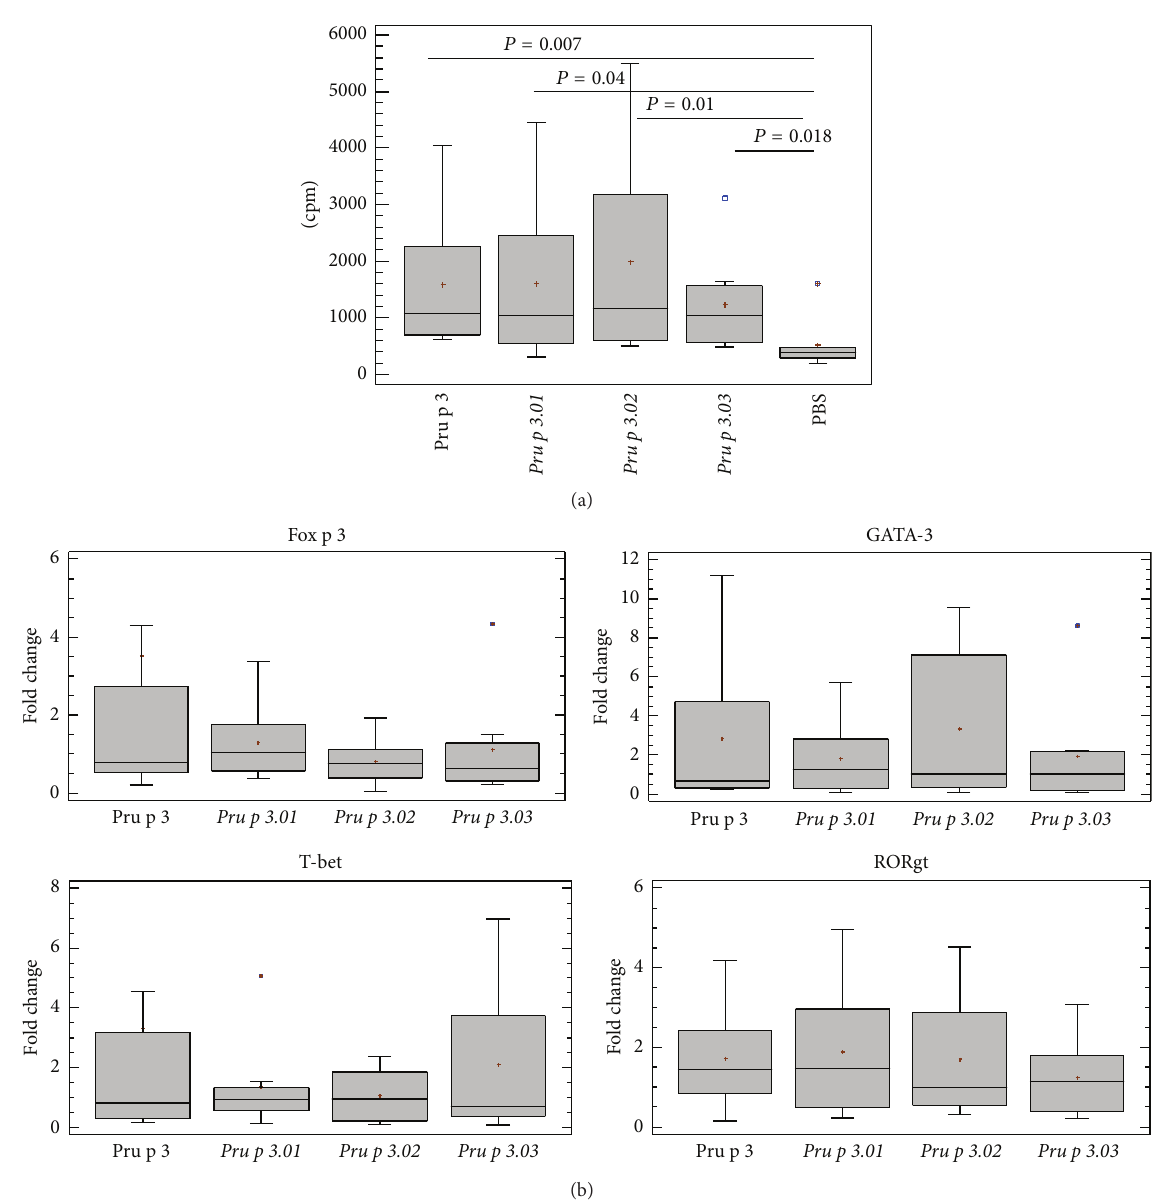
Figure 5: (a) The ratio between IFN 𝛾 and IL4 for T cell line supernatants stimulated with Pru p 3 and its mutant forms is represented ( 𝑛 = 6 ). Statistical analysis was performed by a paired-samples Wilcoxon test ( 𝑃 < 0.05 ). Medians (—) and ranges (bars) are shown. (b) GATA-3, Fox p 3, T-bet, and ROR 𝛾𝜏 relative gene expression levels for T cell lines from peach-allergic patients ( 𝑛 = 6 ). The results are expressed in fold change comparing nonstimulated with stimulated conditions, and statistical significance is indicated ( 𝑃 < 0.05 ) after performing a Wilcoxon test for paired samples. Medians (—) and ranges (bars) are